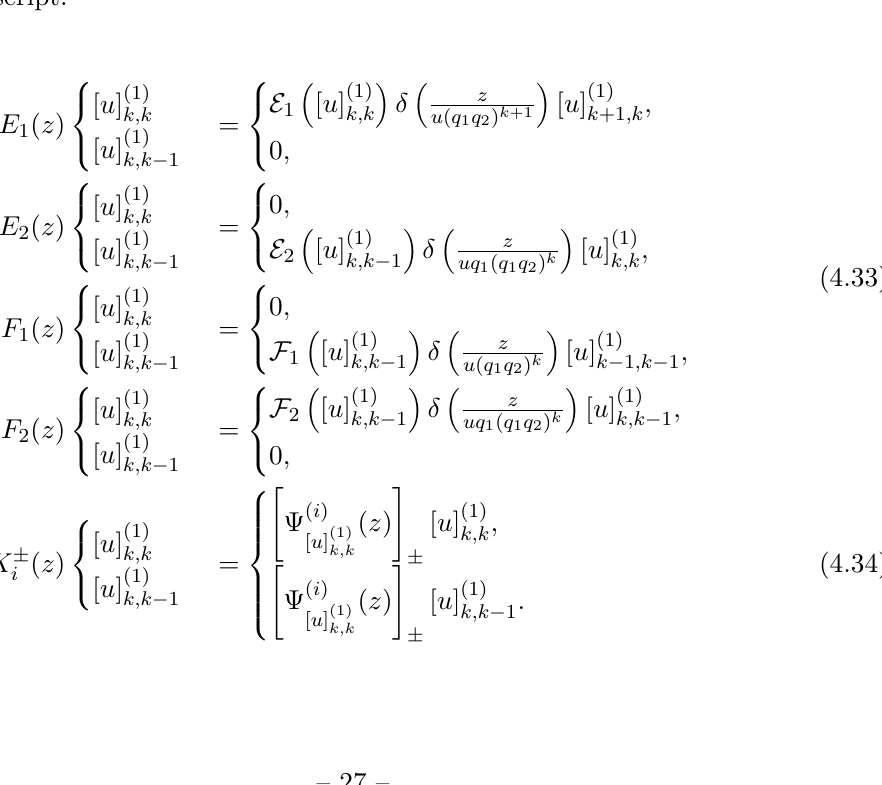
, while the red triangle has coordinate q j +1 q j 1 2